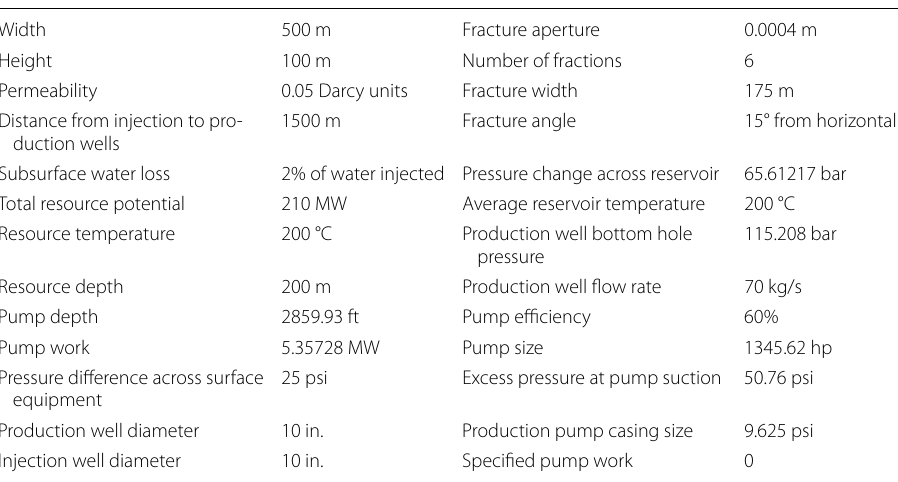
Table 2 Well parameters for the simulation